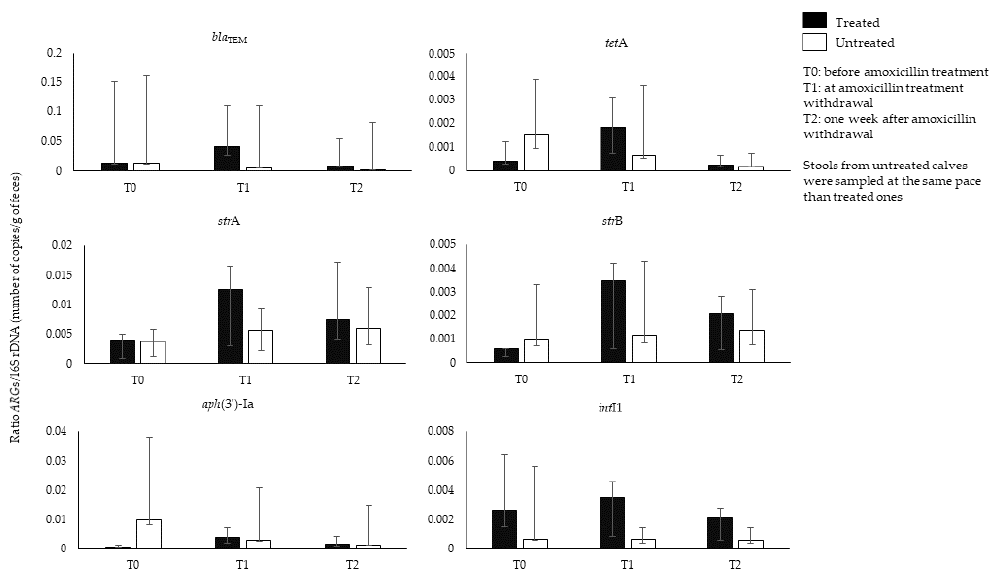
Figure 1. Representation of ARG s/16S rDNA ratio (number of copies/g of feces) evaluated by qPCR in feces of treated and untreated calves at amoxicillin pre-treatment (T0), at amoxicillin withdrawal (T1), and 1 week after amoxicillin withdrawal (T2).